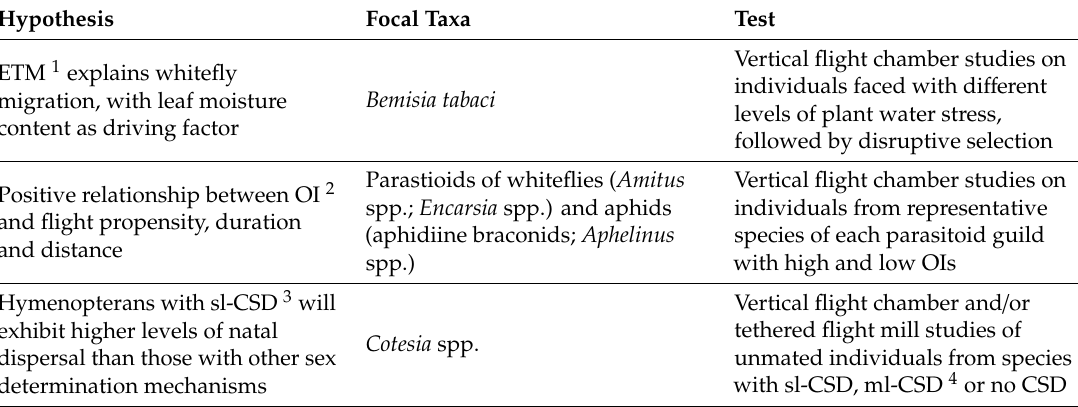
Figure 2. Hypothesized environmental threshold model for migration in the sweet potato whitefly, Bemisia tabaci . Here, the genetically-determined threshold for switching to a migratory phase (blue curve) corresponds to leaf moisture content. Whitefly illustration by Cynthia Harley. Table 1. Summary of major hypotheses and related tests proposed in the